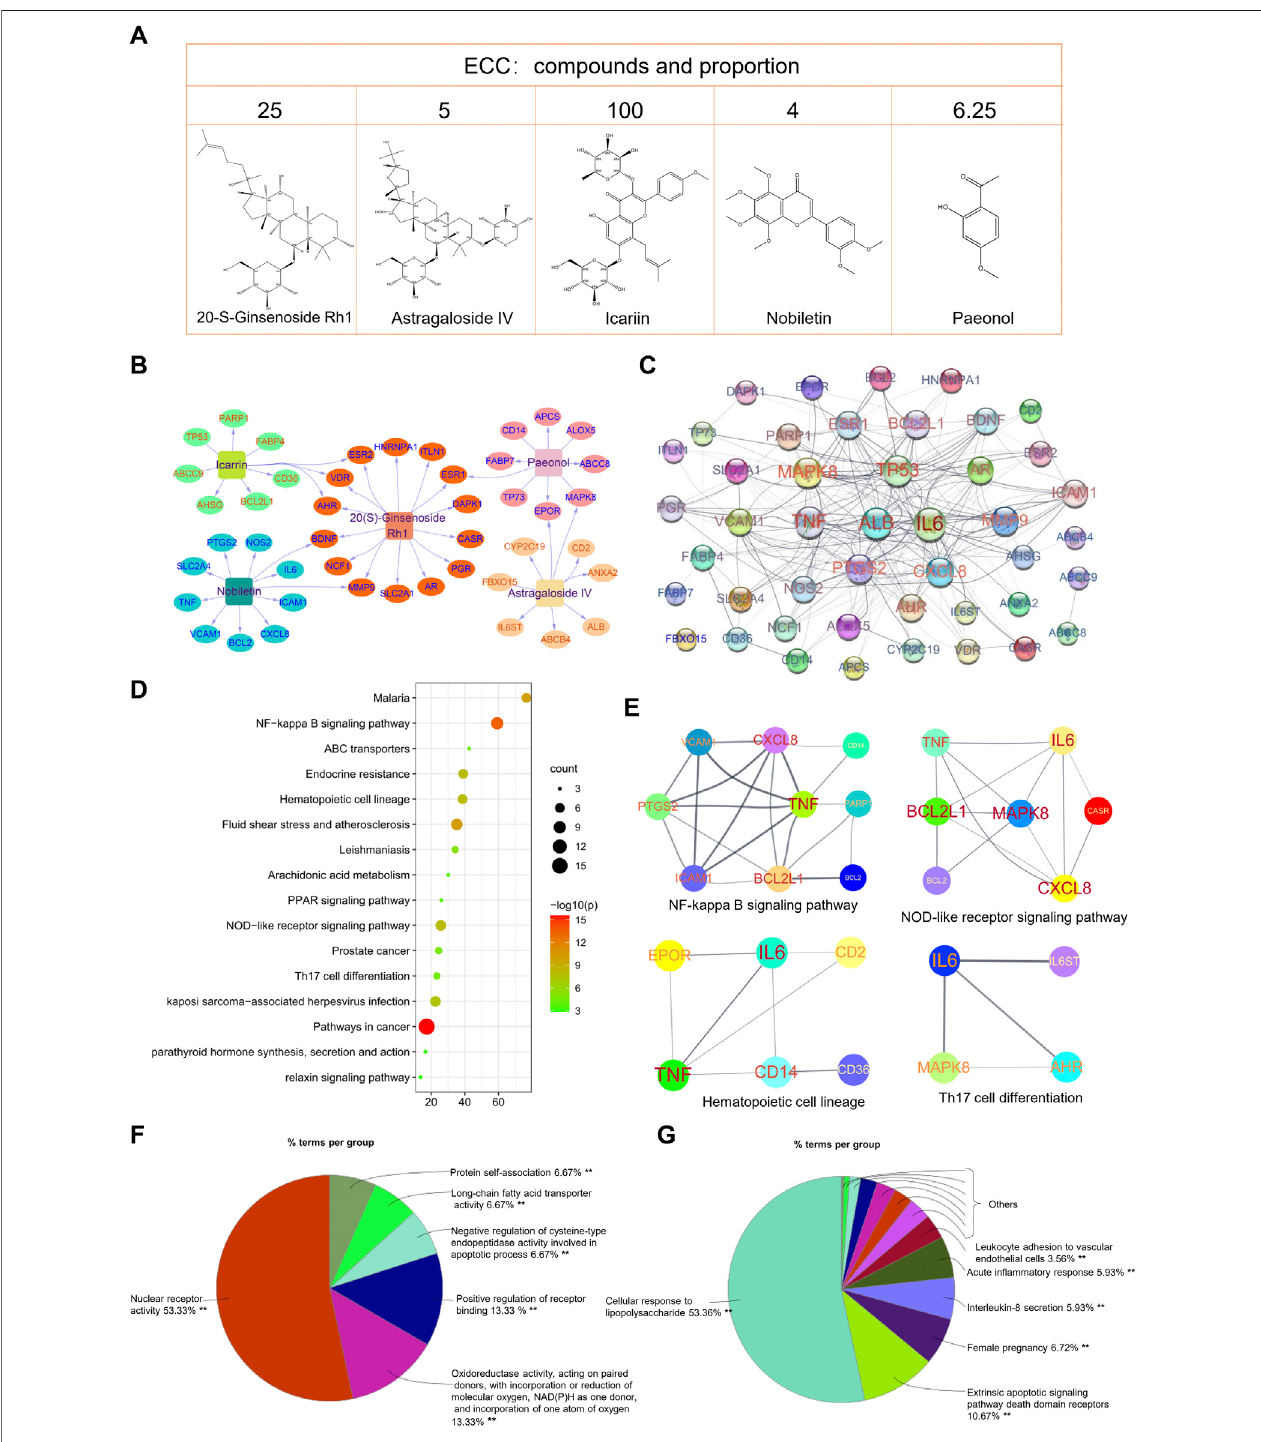
FIGURE 2 | Bioinformatics analysis of ECC targets. (A) Compound – target network of ECC constructed using Cytoscape. (B) Protein – protein network of ECC targets constructed using STRING. The size of the label is proportional to its strength. (C) The top 20 enriched KEGG pathways of ECC targets constructed using Metascape. (D, E) Protein – protein interactions of the proteins contained in the top pathways. (F) Molecular function analysis and (G) biological process analysis for 45 targets constructed using ClueGo in Cytoscape.